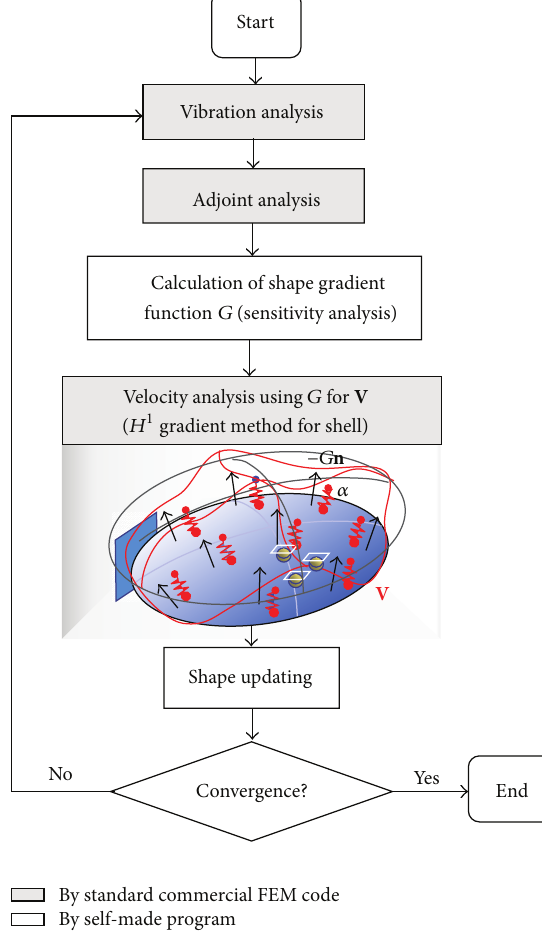
Figure 4: Schematic of the parameter-free optimization